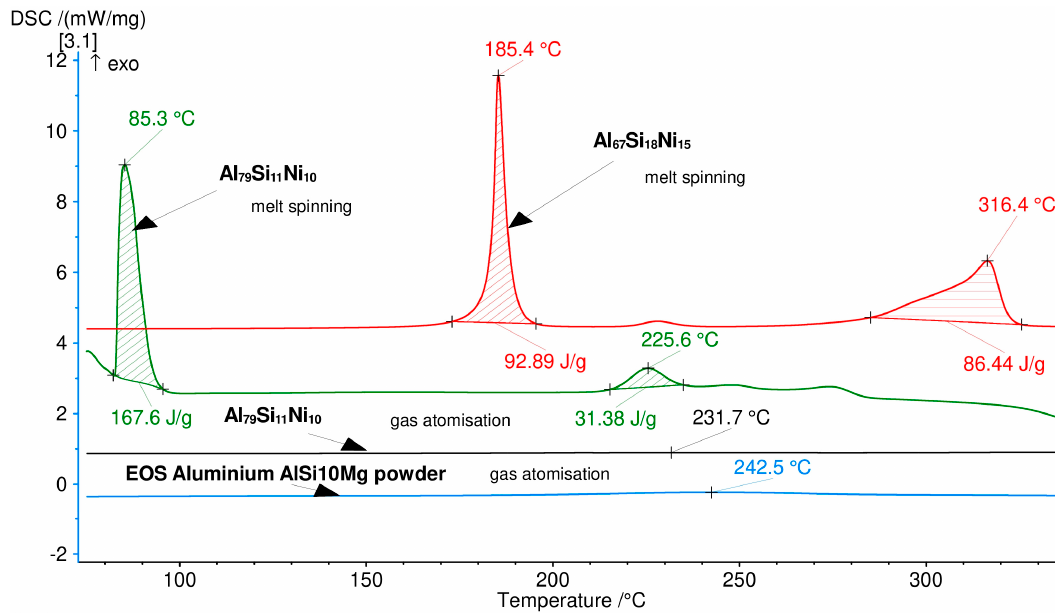
Figure 10. Differential scanning calorimetry (DSC) heating curves for melt-spinning; Al 79 Si 11 Ni 10 –gas atomization, compared to commercially available atomized powder (F357 EOS). The exothermal peaks signify phase transformations, which occur during heating.